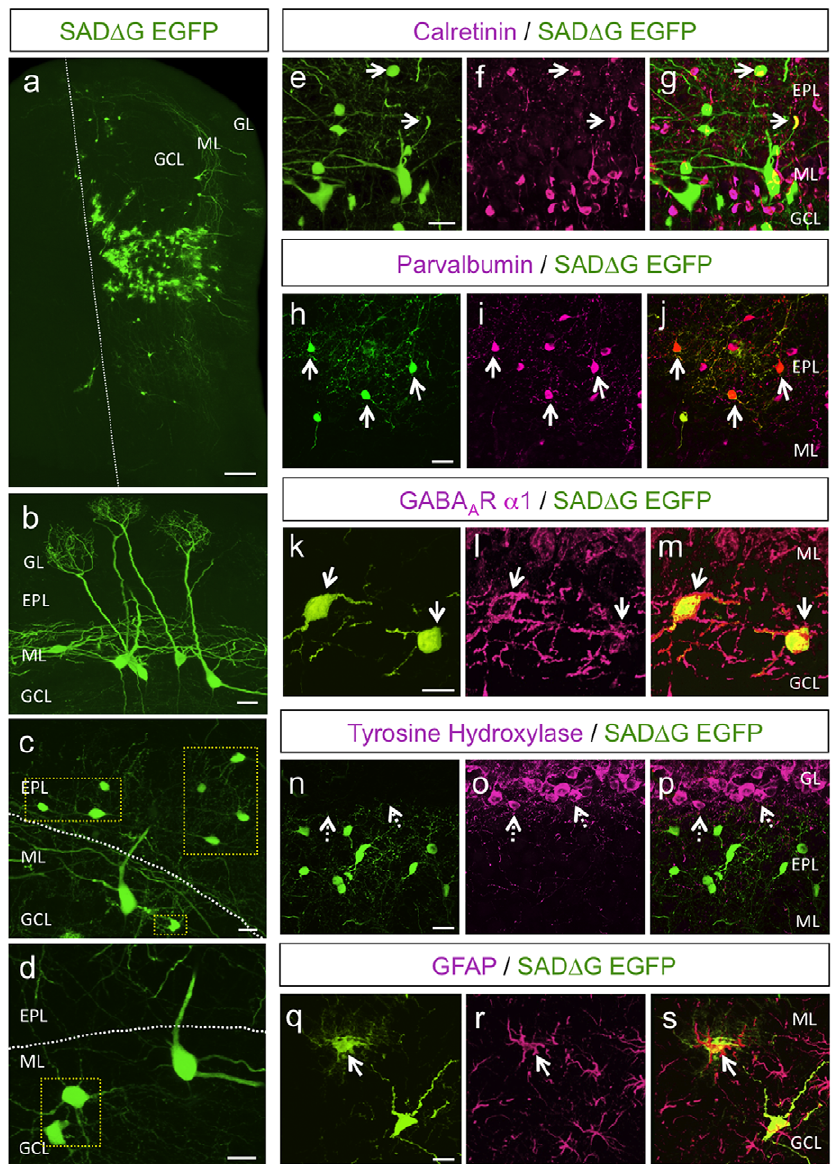
Figure 2. SAD D G-EGFP RV is Retrogradely Transported from Granule Cells to Presynaptic Targets in Olfactory Bulb. (a) A coronal section of olfactory bulb following monosynaptic viral tracing showing a clustered pattern of presynaptic labeling. The dashed line shows the midline through a coronal section of MOB. Scale bar, 100 m m. (b) SAD D G-EGFP expression in presynaptic mitral cells. Scale bar, 25 m m. (c)–(d) SAD D G-EGFP expression in short axon cells in the external plexiform and granule cell layers (hatched yellow boxes). Scale bars, 20 m m. (e)–(g) Partial colabeling of calretinin in SAD D G-EGFP expressing cells. Scale bar, 20 m m. (h)–(j) Partial colabeling of parvalbumin in SAD D G-EGFP expressing cells. Scale bar, 20 m m. (k)–(m) Overlapping expression of GABA A R a 1 in SAD D G-EGFP labeled short axon cells. Scale bar, 15 m m. (n)–(p) SAD D G-EGFP expressing cells do not express tyrosine hydroxylase, and thus are not periglomerular. Dashed arrows point to a tyrosine hydroxylase positive cell not labeled by SAD D G-EGFP RV. Scale bar, 20 m m. (q)–(s) Expression of GFAP in occasional SAD D G-EGFP labeled glial cells. Scale bar, 10 m m. Arrows point to overlapping marker expression in SAD D G-EGFP labeled cells. For all panels, GL, glomerular layer; EPL, external plexiform layer; ML, mitral cell layer; GCL, granule cell layer. and green-only neurons to determine the ratio of presynaptic inputs to granule source cells. In addition to clearly identifiable mitral cells (Fig. 2a–d), reconstructed image stacks revealed two main populations of SACs which have been previously characterized as deep SACs and superficial SACs [24,57,62].